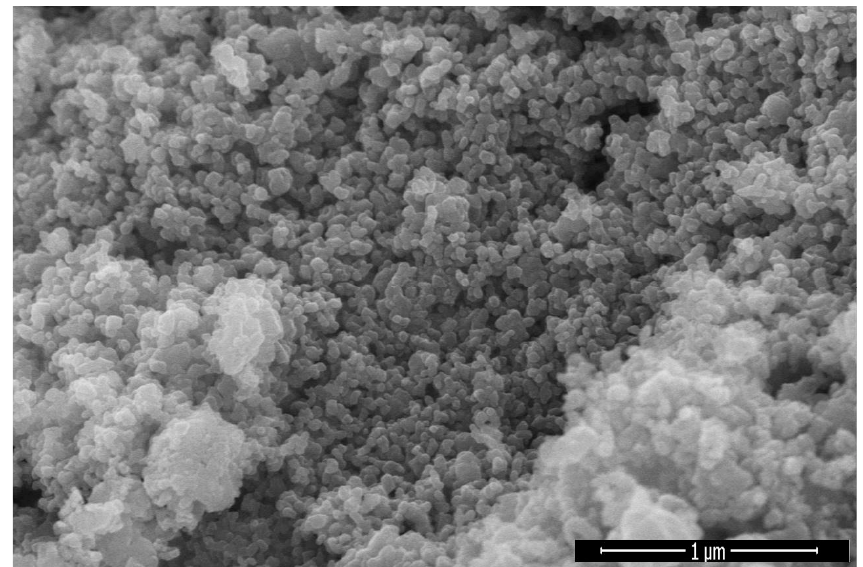
Figure 5. SEM image of Oscillatoria limnetica -mediated IONPs.